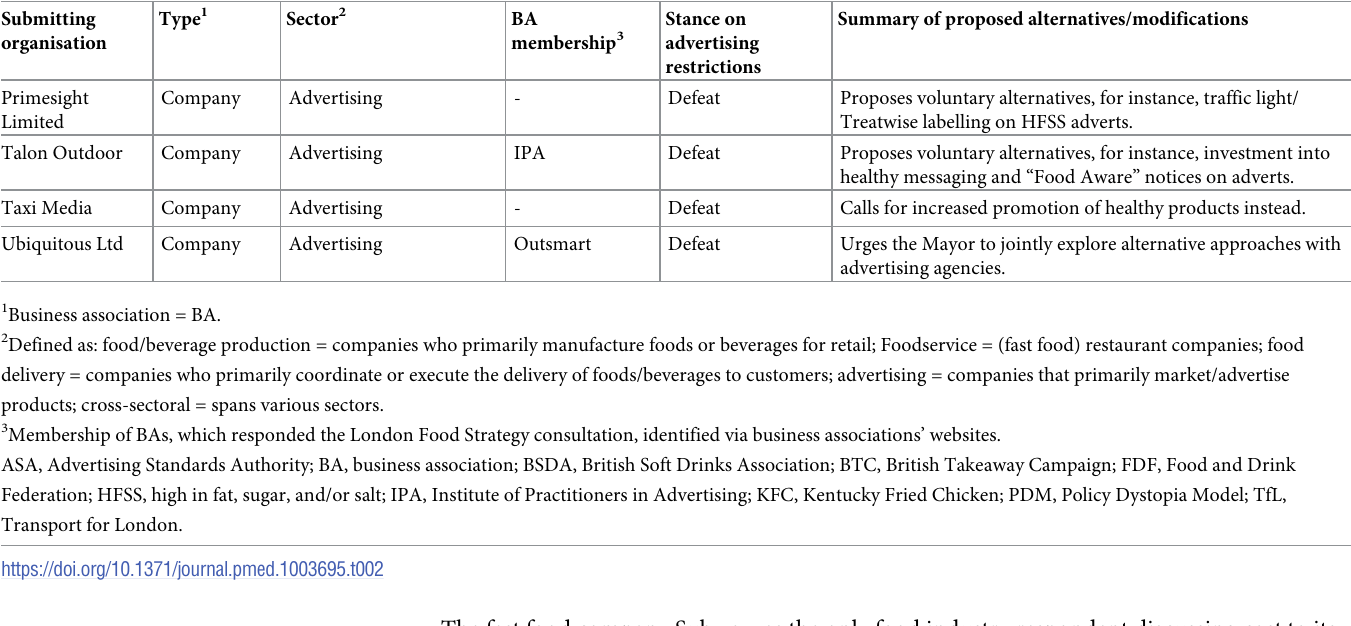
The fast food company Subway, as the only food industry respondent discussing cost to its own business, claimed that, as Londoners are harder to reach through TV and radio advertis- ing, “the impact of the proposed changes to out-of-home [advertising][ . . . ] would be